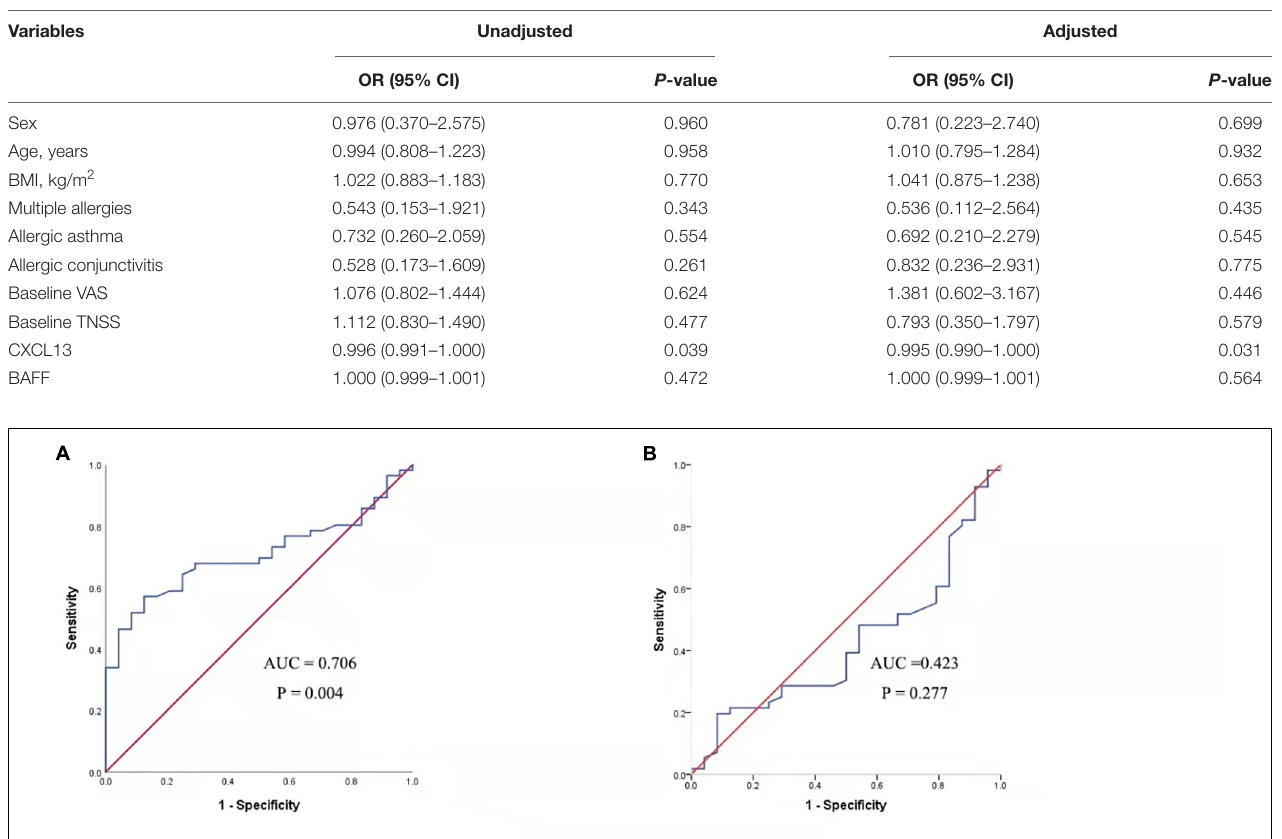
TABLE 3 | Binary logistic regression exploring factors associated with SCIT efficacy.